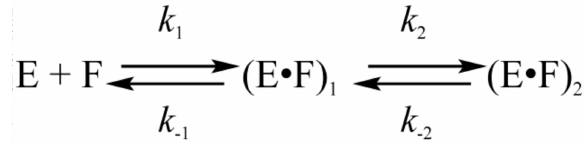
Figure 3. ( A ) Changes in tC O fluorescence intensity during the interaction of Endo III with F-ligand (1 µ M) at various concentrations of the enzyme at 30 ◦ C. Solid curves represent the curves fitted by means of Scheme 2; ( B ) Changes in tC O fluorescence intensity during the interaction of Endo III (2 µ M) with F-ligand (1 µ M) at different temperatures.